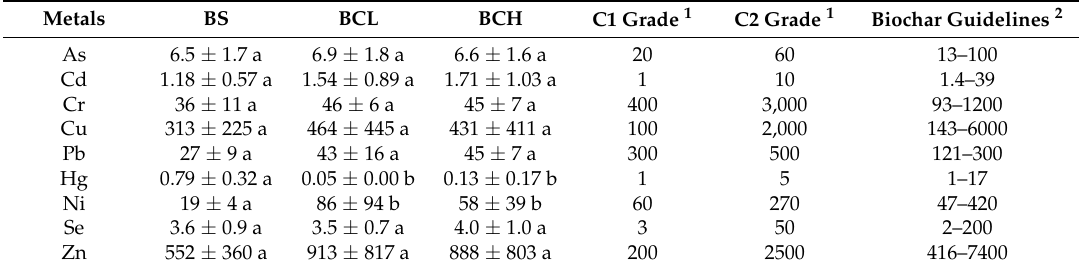
Table 5. Total metal concentrations (mg/kg) of the biosolids and corresponding biochar samples. BS: biosolids, BCL: biochars prepared at low temperature, BCH: biochars prepared at high temperature. Different letters within the same row represent significant differences in the mean